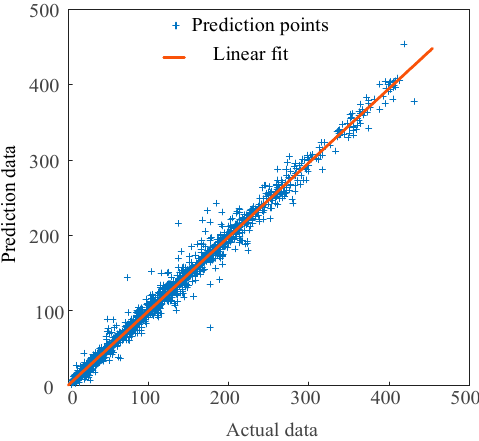
Figure 6. PM 2.5 concentration one-step (1 hour) predicted output fit curve. Table 3. Comparison of five-step (5 hours) prediction results.